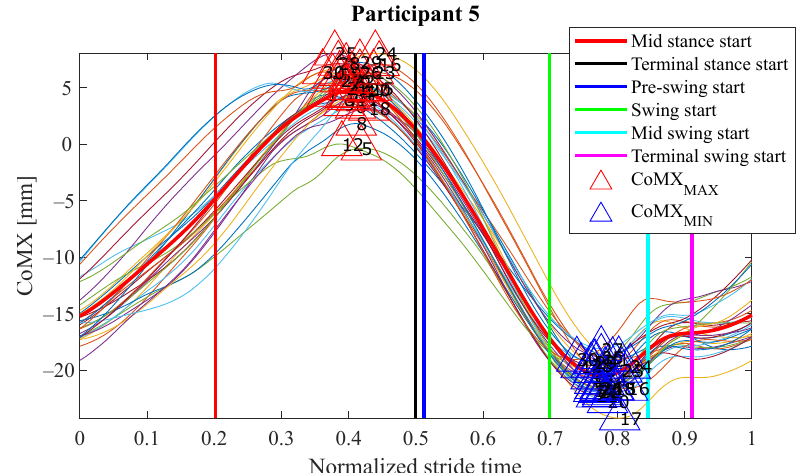
Figure 15. Evolution of the variable CoMX for the test carried out by P5. As can be seen, the event formed by the CoMX maximums may be used both to anticipate terminal stance or pre-swing phases, due to the proximity between the two of